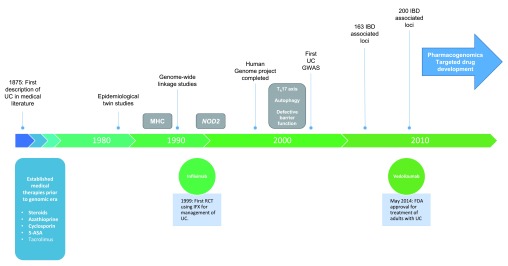
Timeline of genetic discoveries and recent drug developments in IBD.
Adapted from Expert Rev Gastroenterol Hepatol. 2009 513–34.